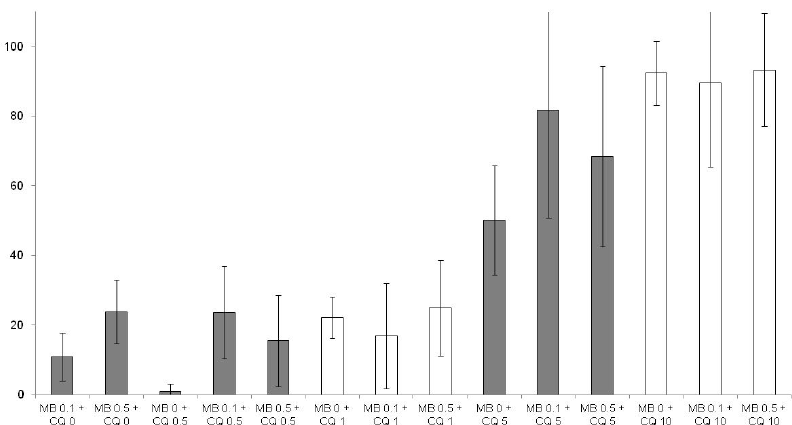
Figure 6. Antiviral activities of methylene blue (MB) at 0.1 and 0.5 µM in combination with chloroquine (CQ) at 0.5, 1, 5 and 10 µM (error bars represent standard deviation of 9 independent experiments).